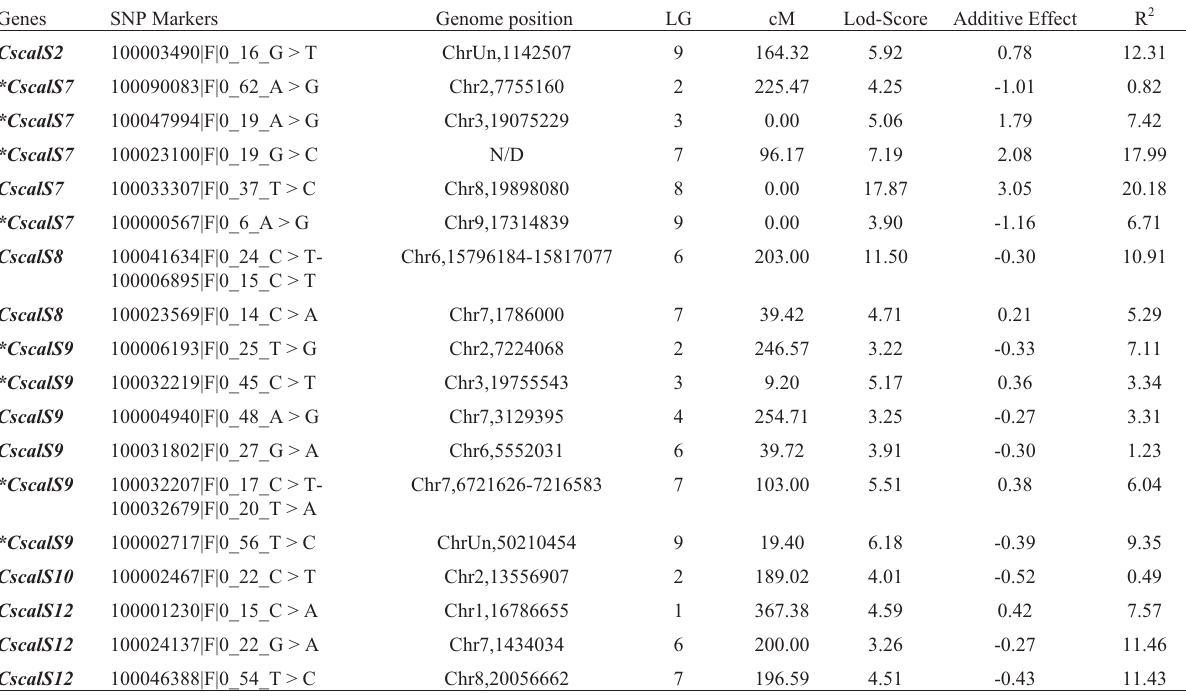
Table 4 - eQTL mapping for CscalS 2, CscalS 7, CscalS 8, CscalS 9, CscalS 10, CscalS 12 in C. sunki linkage map. Genes